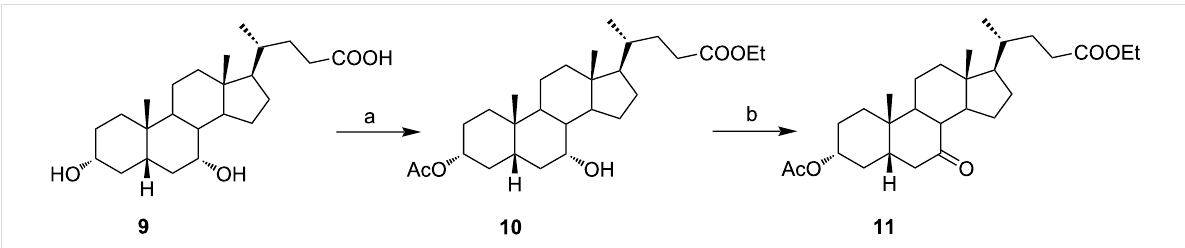
Scheme 2: Synthesis of 7-oxo intermediate 11 from chenodeoxycholic acid ( 9 ). Reagents and conditions: a) EtOAc, pTsOH, reflux, 12 h (66%) and b) K